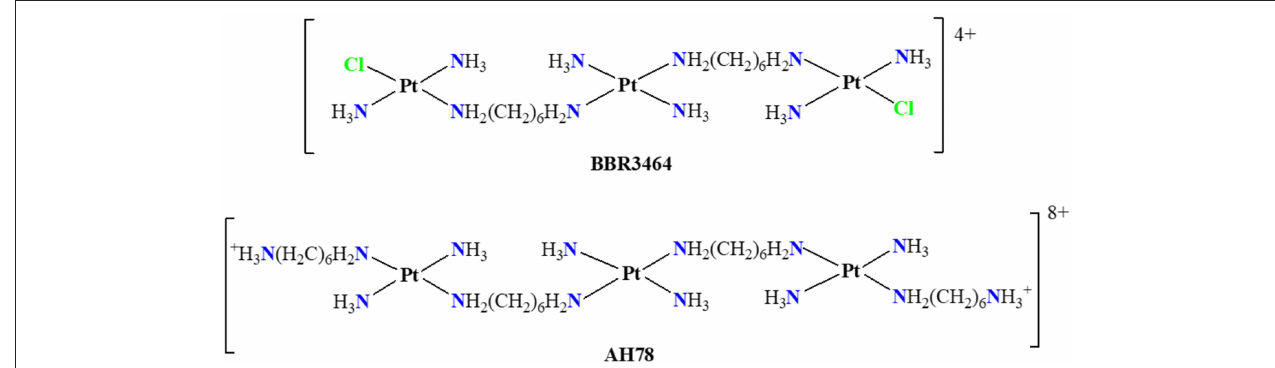
FIGURE 1 | Planar structures of trinuclear platinum(II) complexes, Triplatin (BBR3464), and TriplatinNC